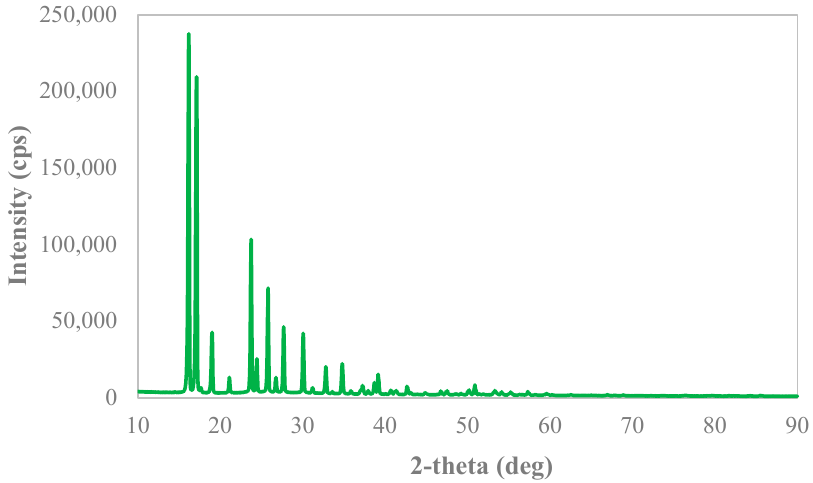
Figure A6. X-ray diffraction spectra of benzoic acid crystallized in neat water.